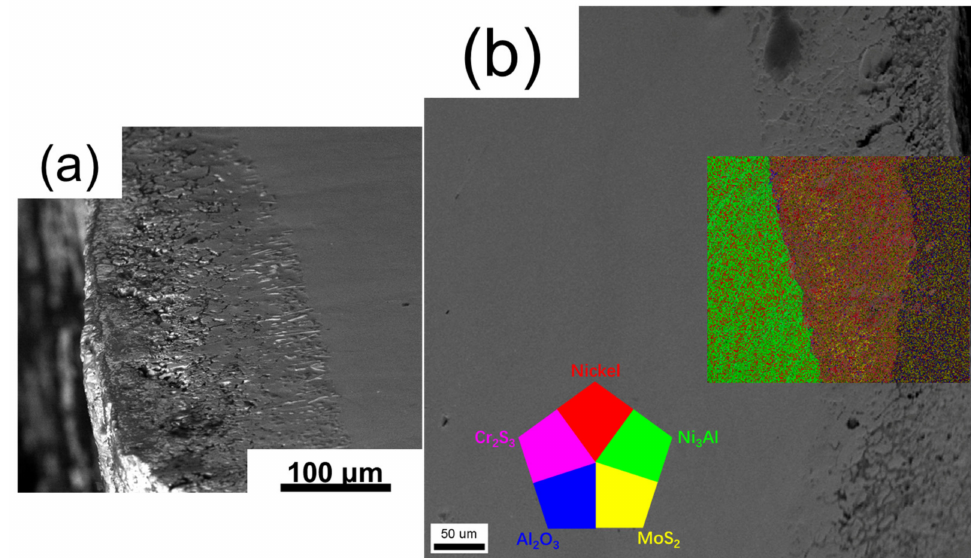
Figure 10. The possible distribution of di ff erent phases of Alloy 1 (4Cr) after 200 h hot corrosion at 900 ◦ C by EBSD. ( a ) The cross-section morphology (SE image) of the sample and ( b ) The distribution of di ff erent phases by EBSD.